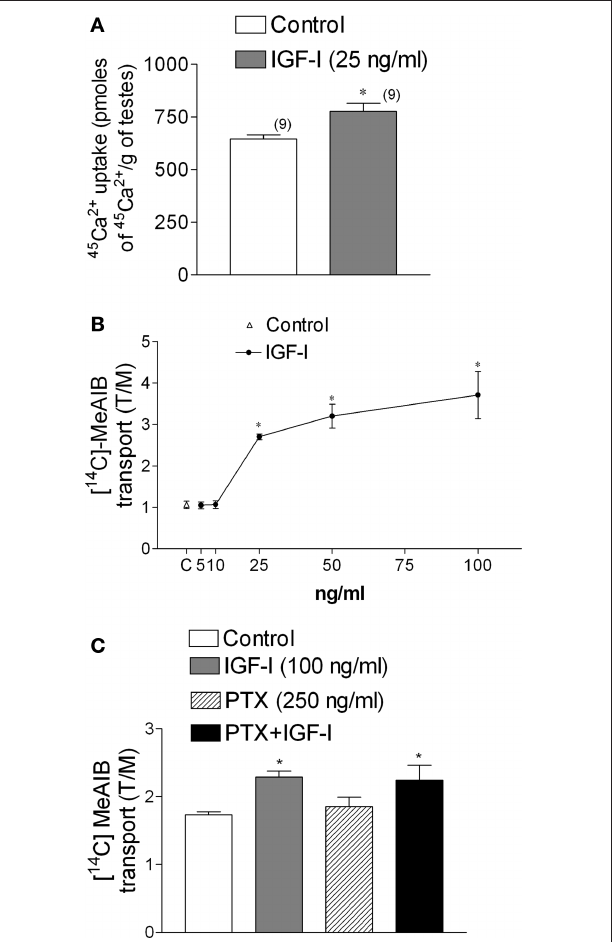
FiGure 6 | iGF-i (25 ng/ml) increases 45 Ca 2 + uptake within 2 min of incubation (A) and [ 14 C]-MeAiB transport at different doses of iGF-i (B). PTX (250 ng/ml) did not affect [ 14 C]-MeAIB transport stimulated by IGF-I (100 ng/ml) (C) . Samples were pre-incubated for 60 min with PTX and incubated for 45 min with [ 14 C]-MeAIB and IGF-I. Statistical analysis: a Student’s t -test was performed in (A) (* p < 0.05; n in brackets from two independent experiments); a two-way ANOVA followed by Bonferroni post test. (B) * p < 0.05; n = 5 in each concentration from five separated experiments, (C) * p < 0.05 as compared with the other groups, n = 5 from one